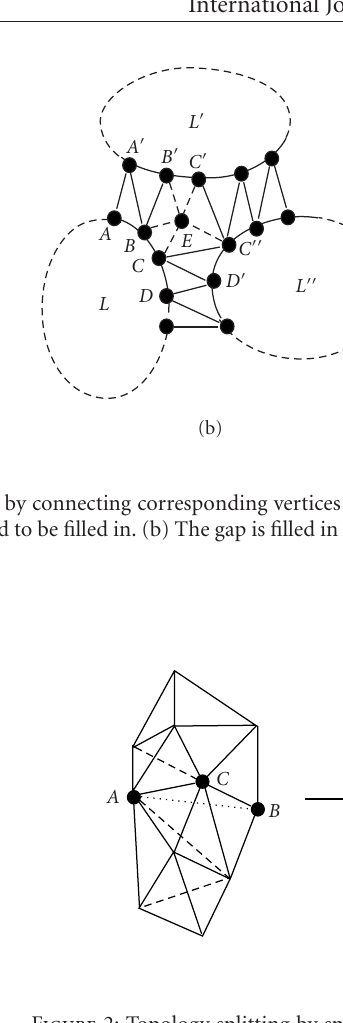
Figure 2: Topology splitting by splitting the virtual face ABC into two faces A 1 B 1 C 1 and A 2 C 2 B 2 whose orientations are opposite to each